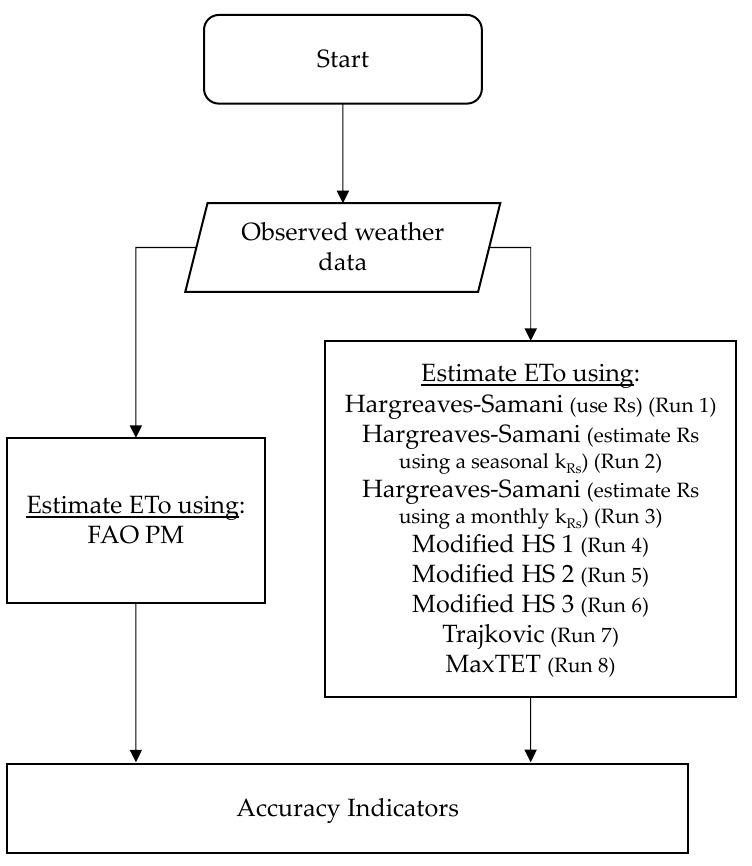
Figure 5. Flow chart presenting the example application runs performed with ETo Tool. Table 1. Location coordinates, elevation and distance to the sea.